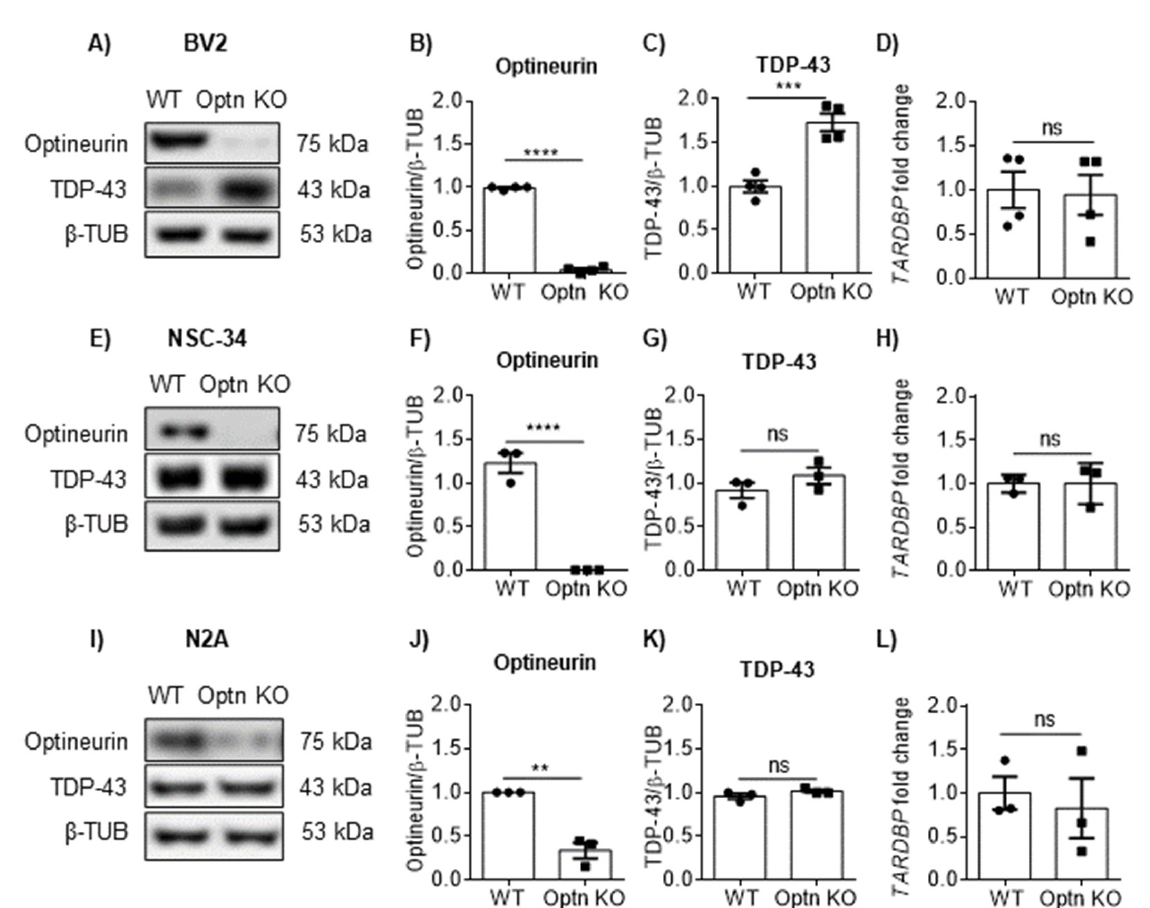
Figure 1. Loss of optineurin leads to an accumulation of TAR DNA-binding protein 43 kDa (TDP-43) protein in microglial but not in neuronal cell lines. ( A ) Western blotting for optineurin and TDP-43 in WT and Optn knockout (KO) microglial cell lines. ( B , C ) Bar charts show the densitometric analysis of optineurin and TDP-43 protein levels normalized to β -tubulin in the BV2 cell line. ( D ) mRNA for TARDBP in WT and Optn KO BV2 cell lines was assessed by RT-PCR, shown as a difference in fold gene expression (2 − ∆∆ Ct ) to GAPDH . ( E ) Western blotting for optineurin and TDP-43 in WT and Optn KO NSC-34 neuronal cell lines. ( F , G ) Bar charts show the densitometric analysis of optineurin and TDP-43 protein levels normalized to β -tubulin in NSC-34. ( H ) mRNA for TARDBP in WT and Optn KO NSC-34 cell lines was assessed by RT-PCR. ( I ) Western blotting for optineurin and TDP-43 in WT and Optn KO N2A neuronal cell lines. ( J , K ) Bar charts show the densitometric analysis of optineurin and TDP-43 protein levels normalized to β -tubulin in N2A. ( L ) mRNA for TARDBP in WT and Optn KO N2A cell lines was assessed by RT-PCR. An average ± SEM from 3 independent experiments is shown. Statistical analysis was performed by Student’s t -test: ns, not significant, ** p < 0.01, *** p < 0.001, **** p <